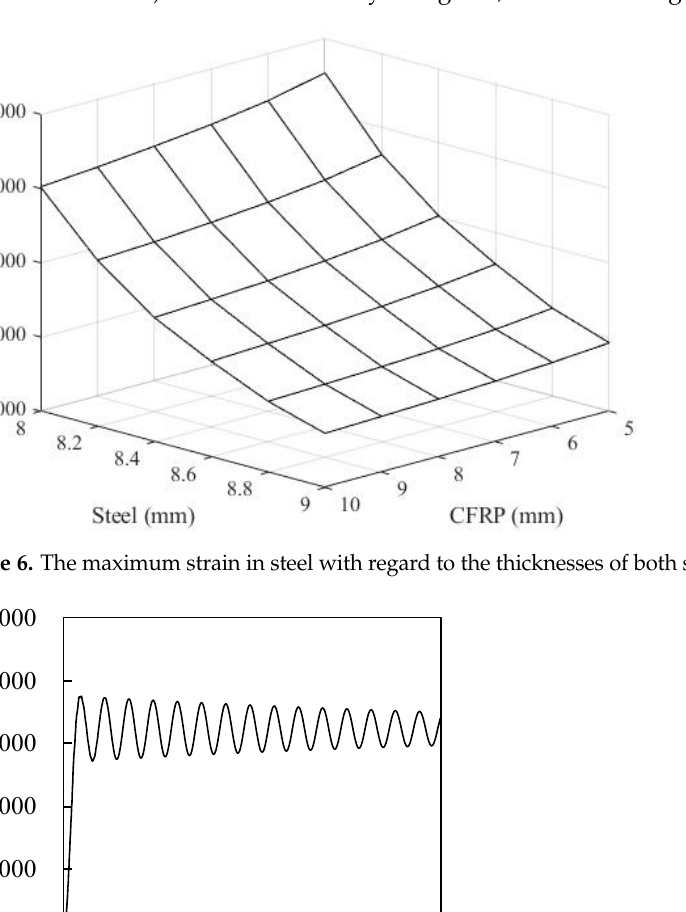
Figure 5. Stress development in steel of the hybrid system containing 8.4 mm thick steel slab and 8.0 mm thick ϕ 100 mm CFRP frame.